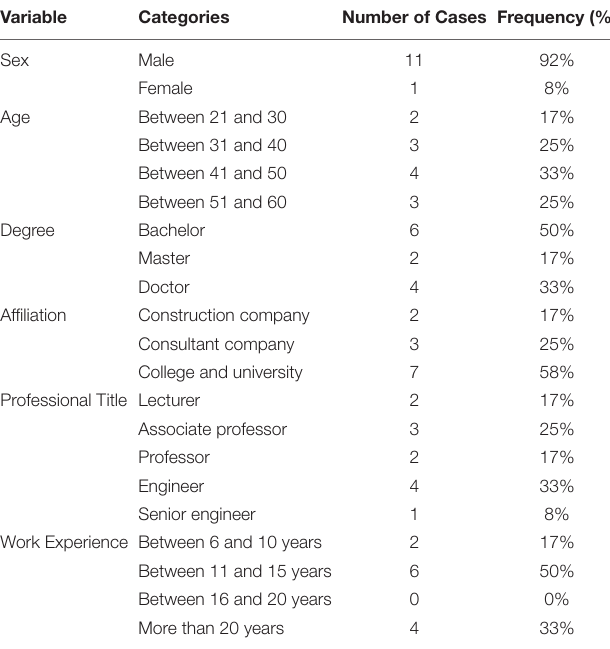
TABLE 8 | The initial value of factors.